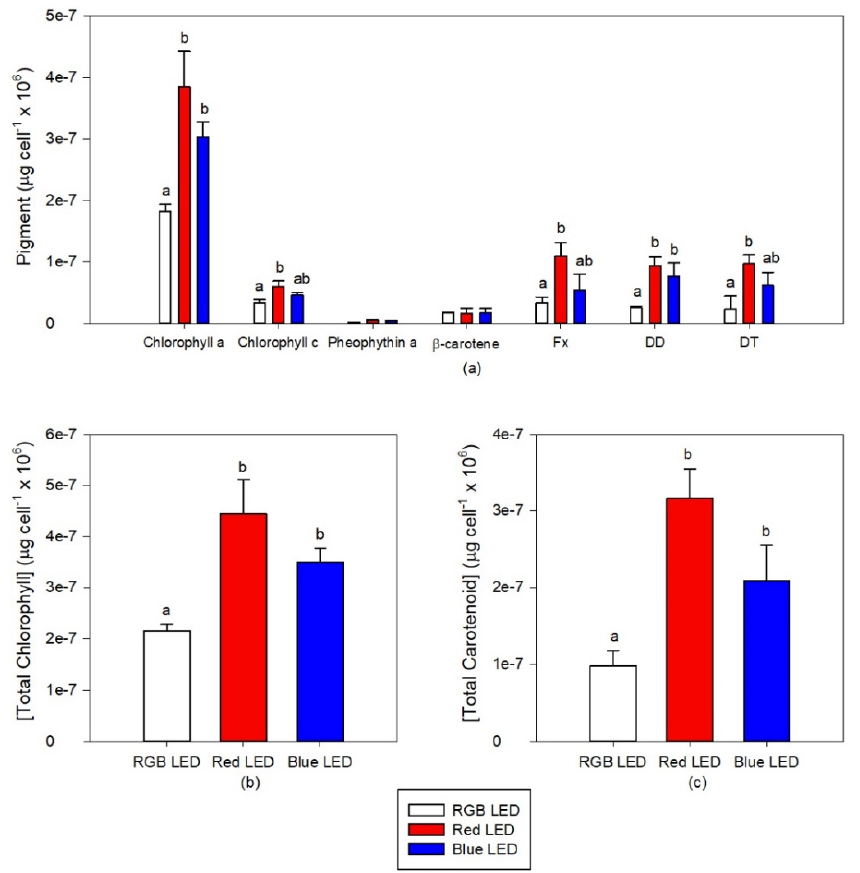
Figure 5. Pigments profiles ( a ), total chlorophyll ( b ) and total carotenoids ( c ) contents of the P. tri- cornutum cultures ( N = 5) subjected to the three light treatments at the end of the 96 h exposure period (average ± standard error, letters denote significant differences between light treatments at p < 0.05).